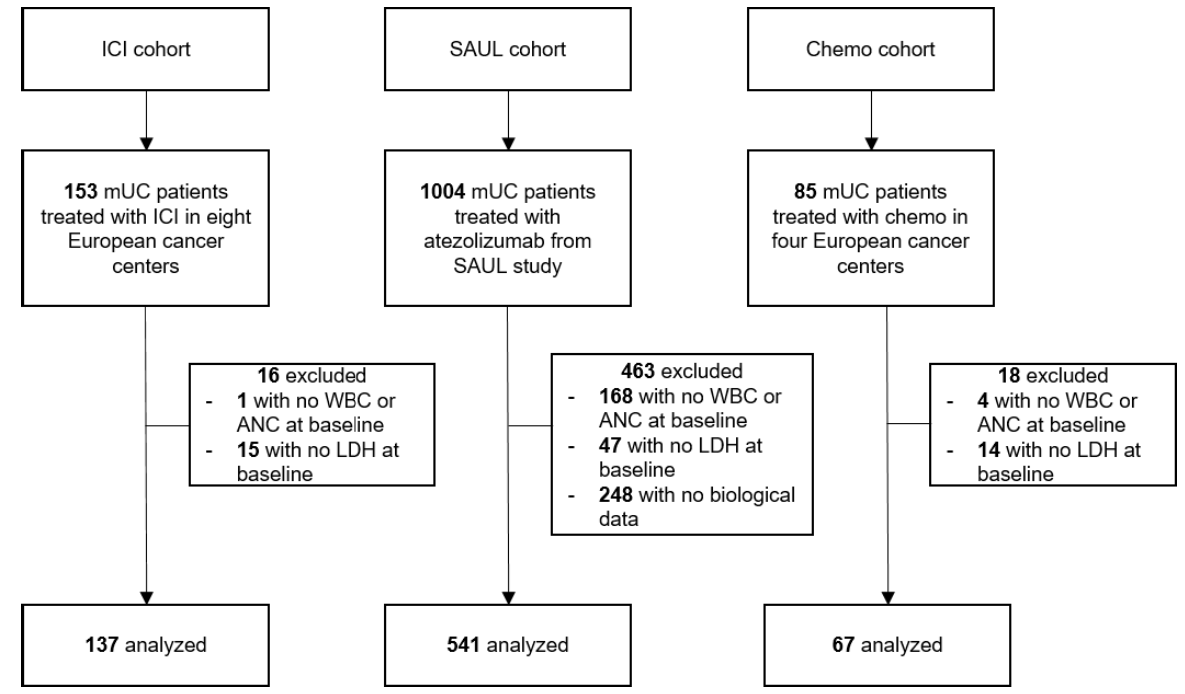
Figure 1. Flow diagram of the study population. ANC: absolute neutrophil count; Chemo: chemotherapy; ICI: Immune checkpoint inhibitor; LDH: lactate dehydrogenase; mUC: metastatic urothelial cancer; WBC: white blood cell. Table 1. Baseline patient and disease characteristics for the ICI, SAUL and Chemo cohorts. ANC: absolute neutrophil count; Chemo: chemotherapy; dl: deciliter; dNLR: derived neutrophils/(leuko- cytes minus neutrophils) ratio; ECOG: Eastern Cooperative Oncology Group; g: grams; ICI: immune checkpoint inhibitor; LDH: lactate dehydrogenase; LIPI: lung immune prognostic index; mo: months; n: number; NA: not available; PD-L1: programmed death-ligand 1; ULN: upper limit of normal.